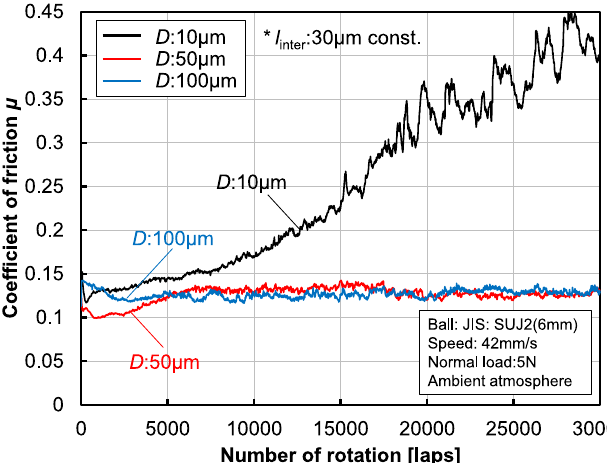
Fig. 5. Evolution of COF during ball-on-disk friction test of micro-textured DLC fi lms with different texture diameters under constant interspace of 30 m